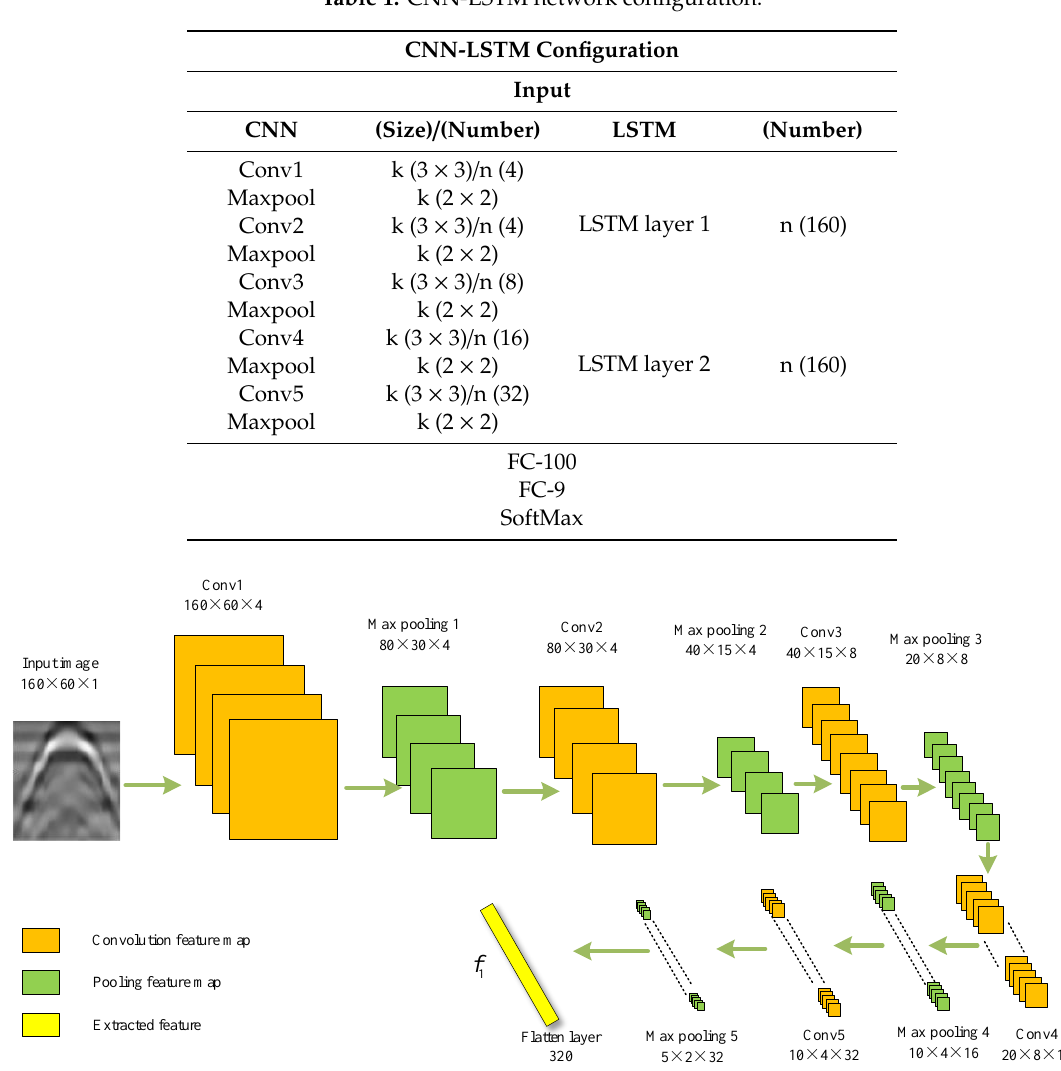
Figure 8. The CNN architecture with the input of the hyperbola region. Table 1. CNN-LSTM network configuration.